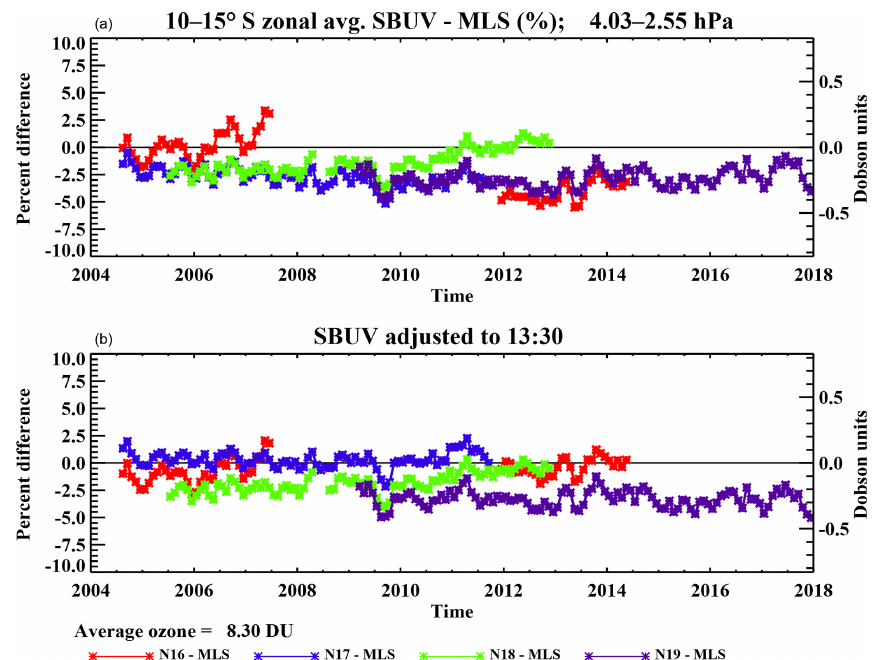
Figure 11. Same as Fig. 10 but for the 10–15 ◦ S latitude band at 4–2.5hPa